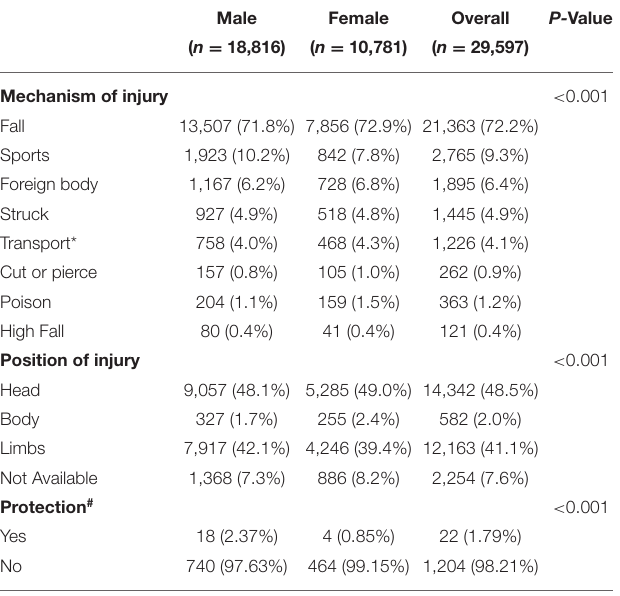
TABLE 3 | Mechanism of child unintentional injury in the emergency